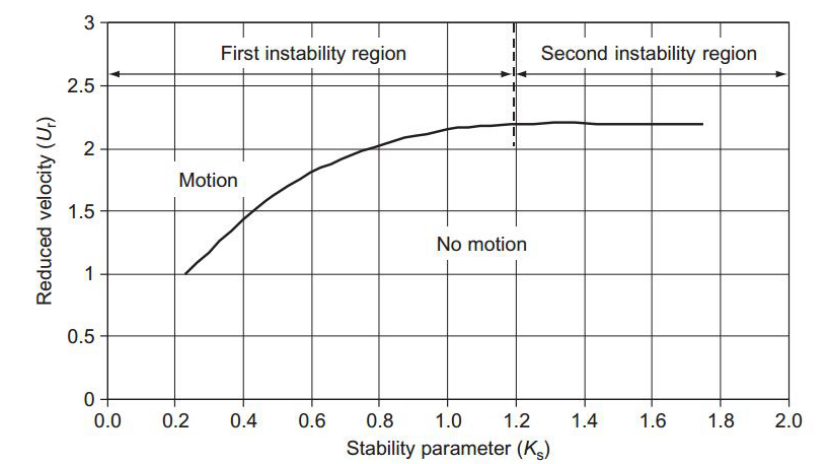
Figure 2. Reduced velocity for In-line oscillations based on Stability parameter K s [17]. (Figure 2